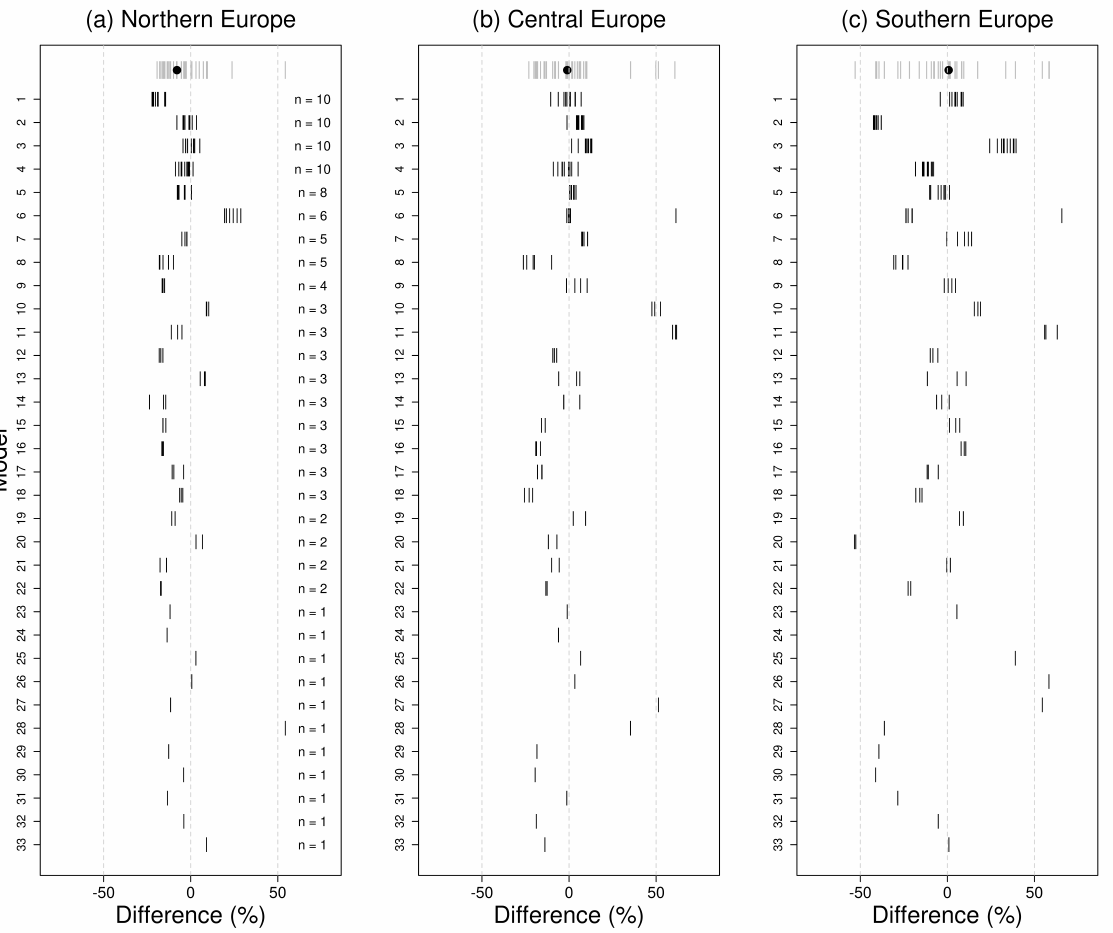
Figure 2. Relative difference in duration RLs (model – EOBS) calculated for all members of each model ensemble in three regions: (a) north- ern Europe, (b) central Europe and (c) southern Europe. First row provides the ensemble mean of each model (grey lines) and the multi-model ensemble median (black dot), while each subsequent row provides the relative difference for each ensemble member of models 1–33 and the number of members ( n ) in each model